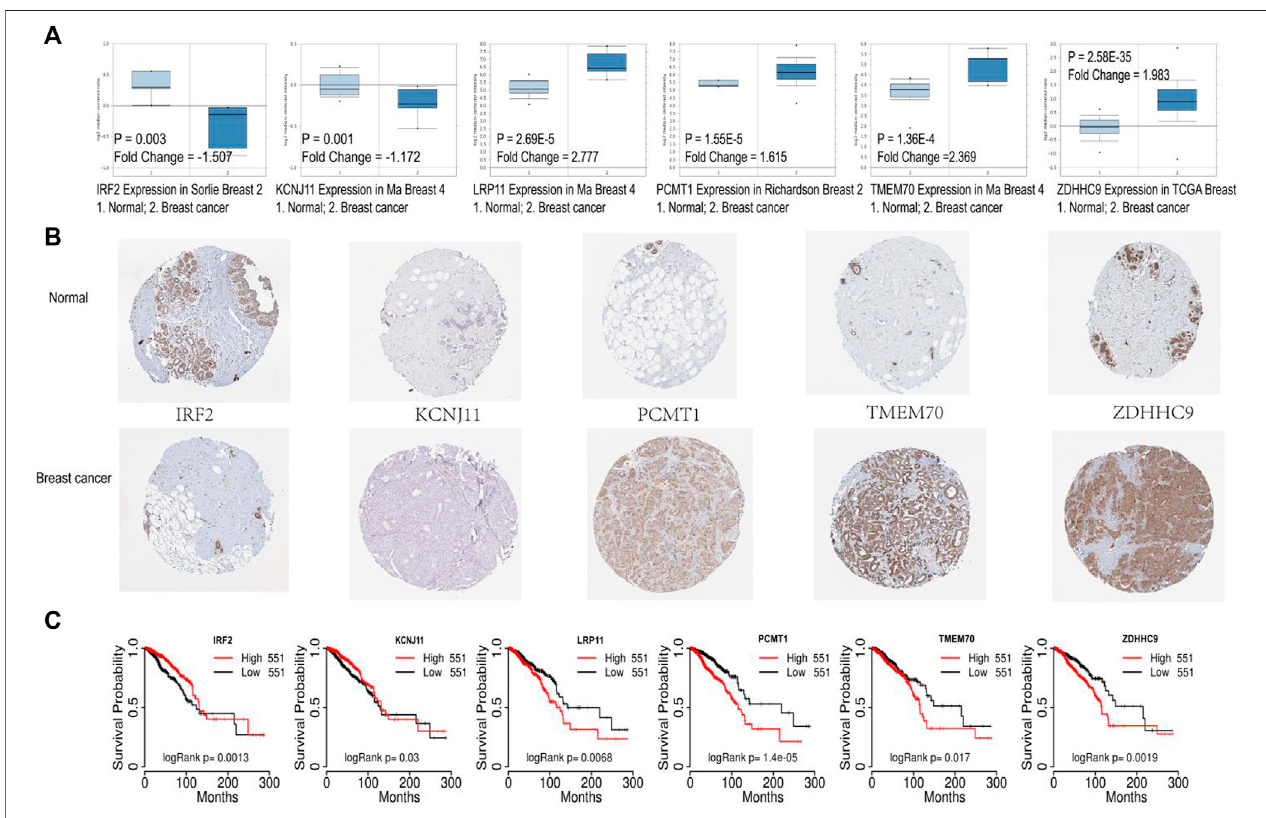
FIGURE 7 | Validation of the six signature genes. (A) The expression of the six signature genes in breast cancer and normal tissue in Oncomine database. (B) The protein expression levels of the six prognostic genes in Human Protein Atlas database. (C) Survival analysis of the six prognostic genes based on TCGA portal.